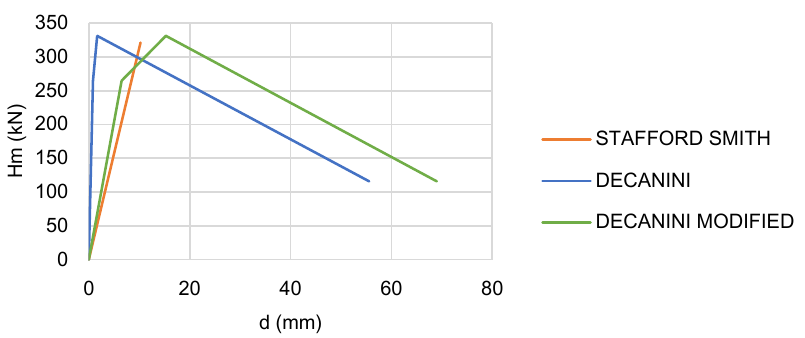
Figure 7. Comparison of infill panel equivalent strut constitutive models.